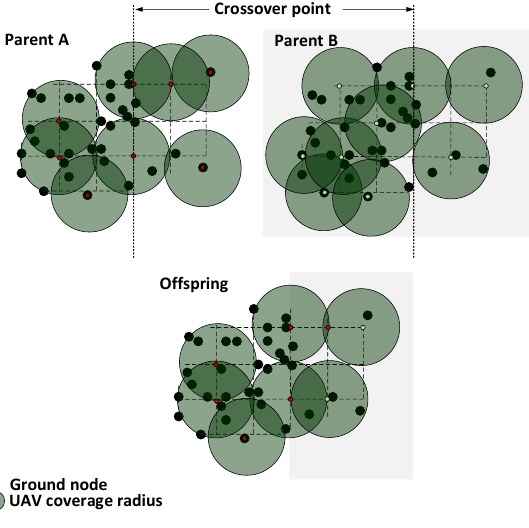
Figure 4. Crossover procedure.